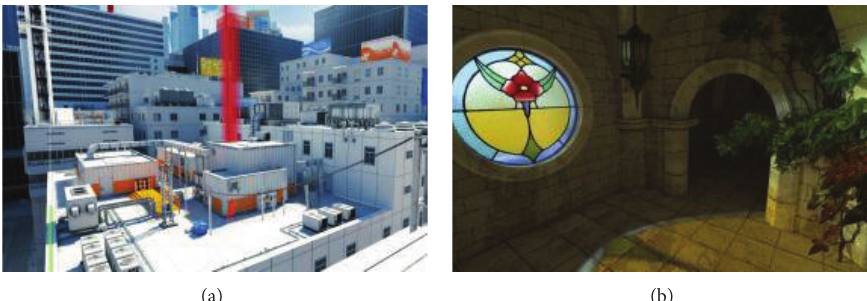
Figure 3: Precalculated global illumination, calculated using Unreal technology. (a) Mirror’s edge, lit by Be¨ast. (b) Scene lit by Lightmass.